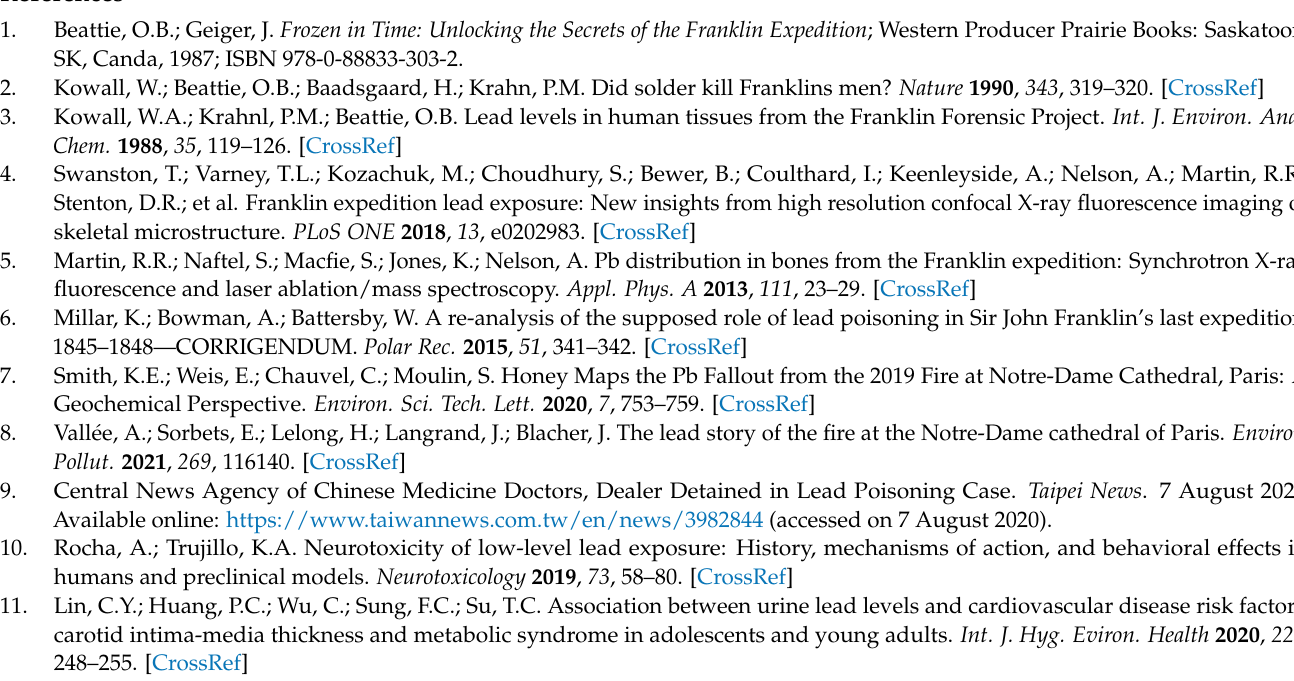
Video S5: Ratio image sections of Figure